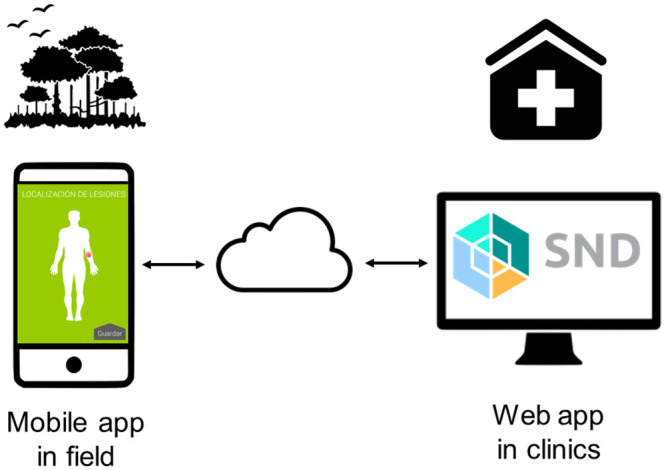
Data flow.Users capture the information in the field via the mobile application and synchronize data when a connection is available, via secure cloud storage. The data can be accessed and analyzed by study physicians or researchers via the desktop web application. Sources: the app screen images are created by the authors; other images are in the public domain, taken from publicdomainvectors.org (cloud) and icon-library.net (others).